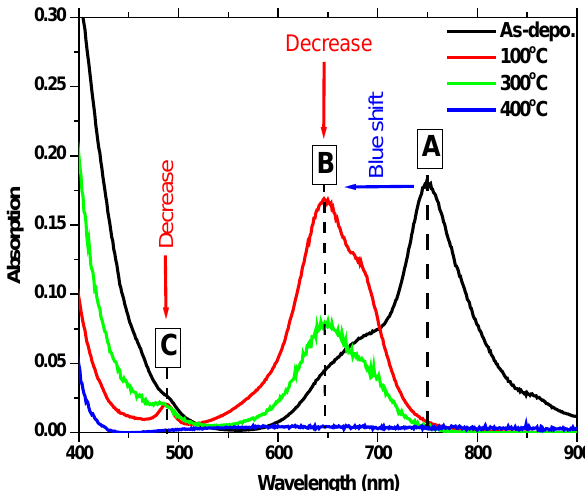
Figure 3. Absorption spectra of FCrPc deposited and treated with different temperatures.